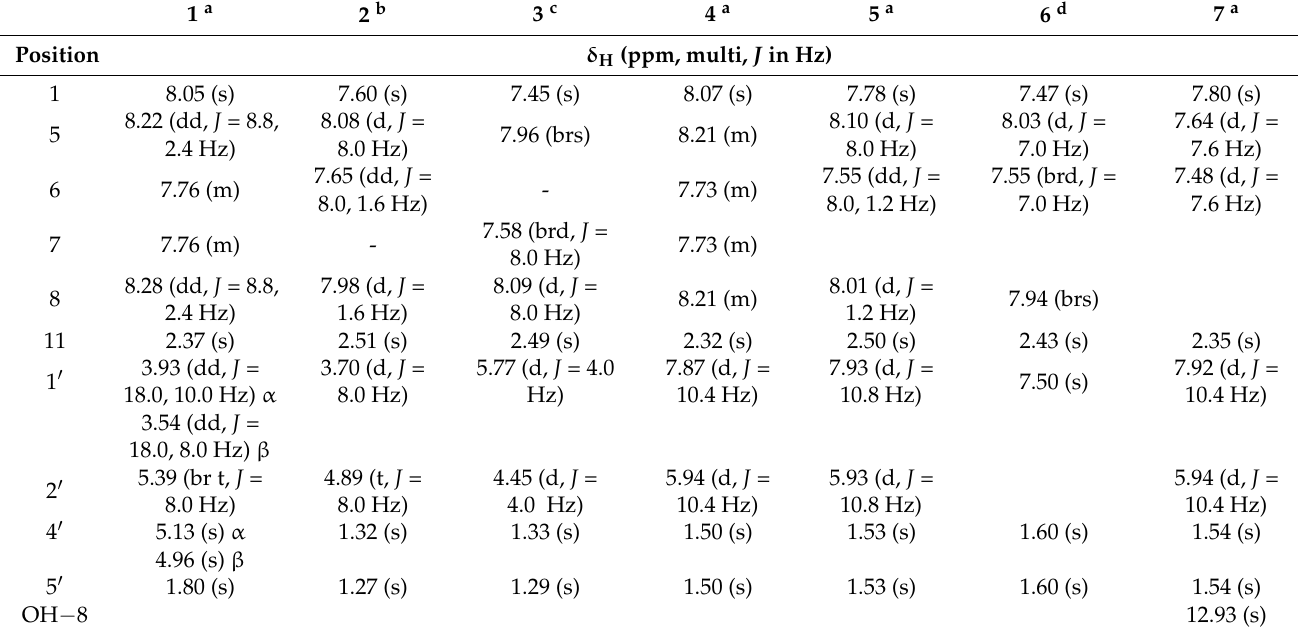
Table 1. The 1 H NMR spectral data of compounds 1 – 7